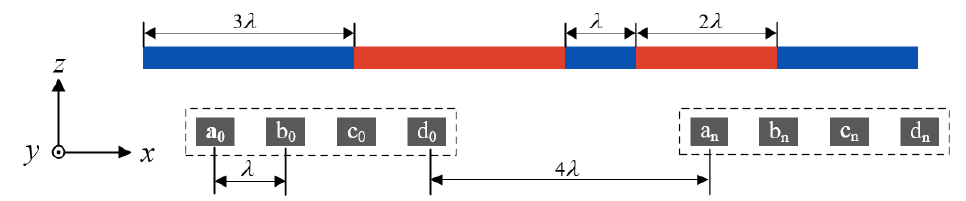
Figure 5. C oded permanent magnet array measurement